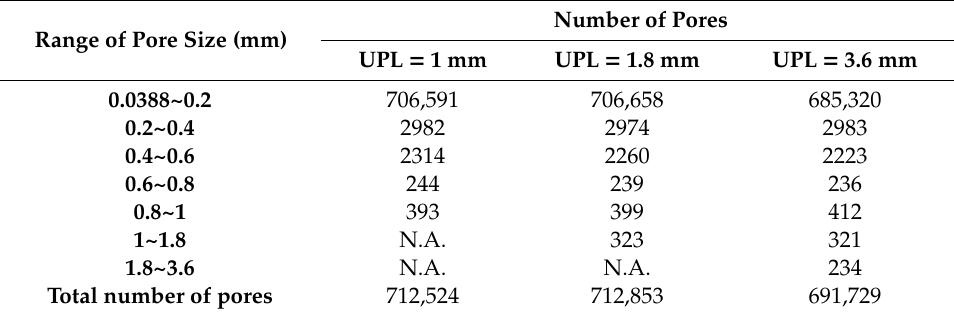
Table 2. Pore size distribution analyzed using various pore size limits.